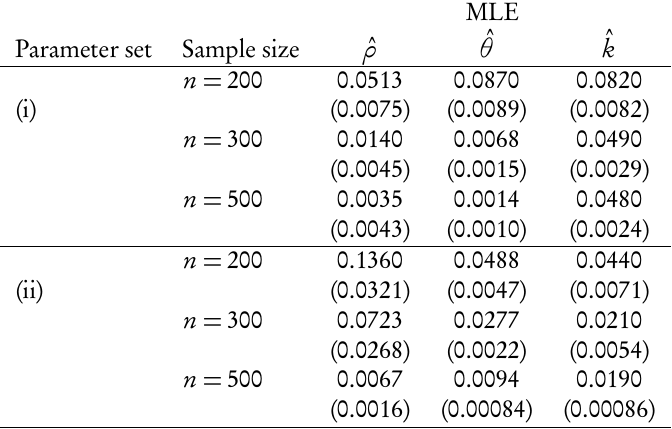
Bias and standard errors in the parenthesis of the estimators of the parameters θ , ρ and k of the MYD for the simulated data